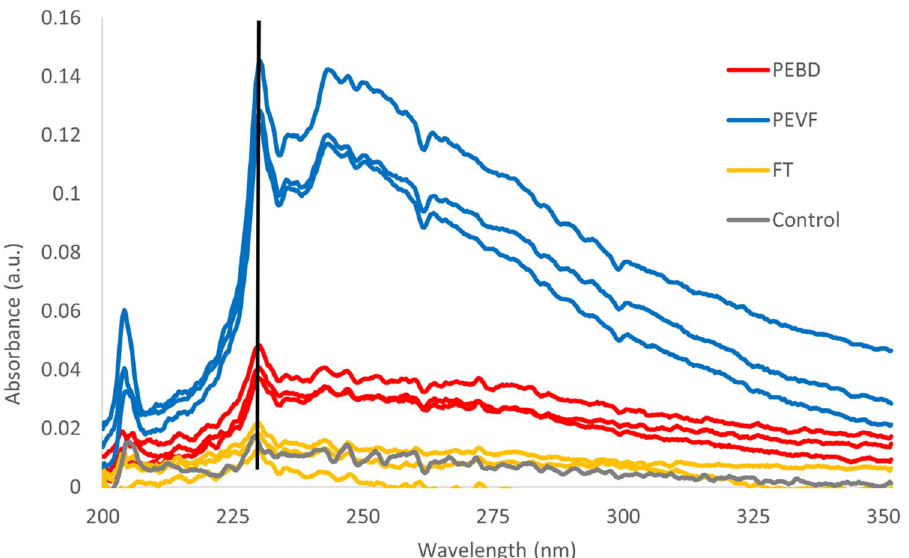
Figure 3. Absorption spectra of HDPE breakdown fractions. Absorbance measurements for the triplicate break down fractions and a tap water used as a control. Black vertical line highlights peak maxima at 230